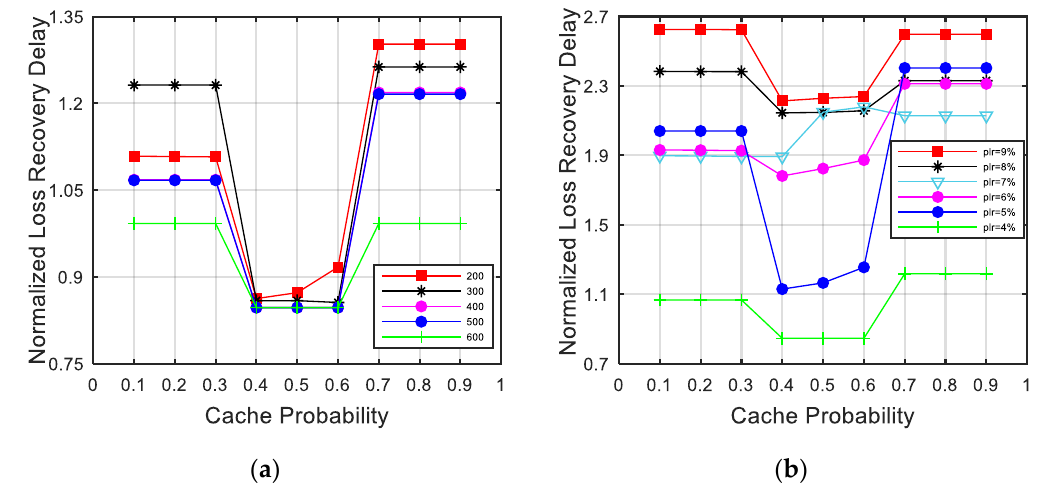
Figure 6. Relationship between normalized loss recovery delay (NLRD) and cache probability. ( a ) Relationship between